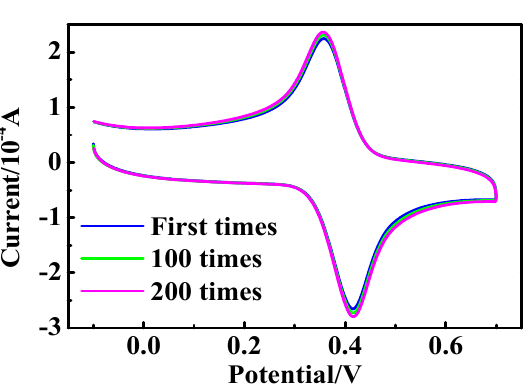
Table 2. Comparison of electrocatalytic oxidation performance of the HQ on different modified electrodes. Thermally reduced carbon nano-fragment Zinc nanoparticles-loaded carbon fiber